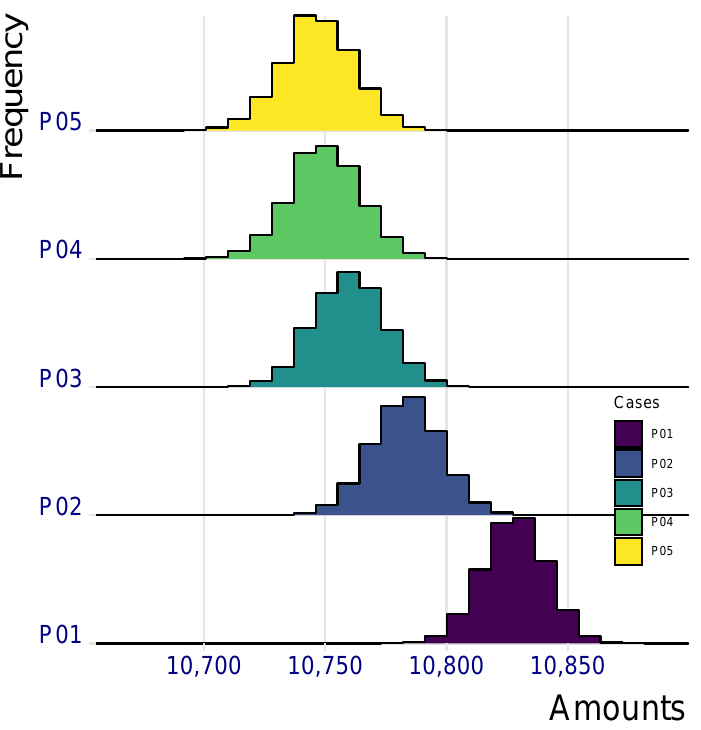
Figure 7. Impact of different dispersion parameters: empirical distributions of the total payout at time t = 5.